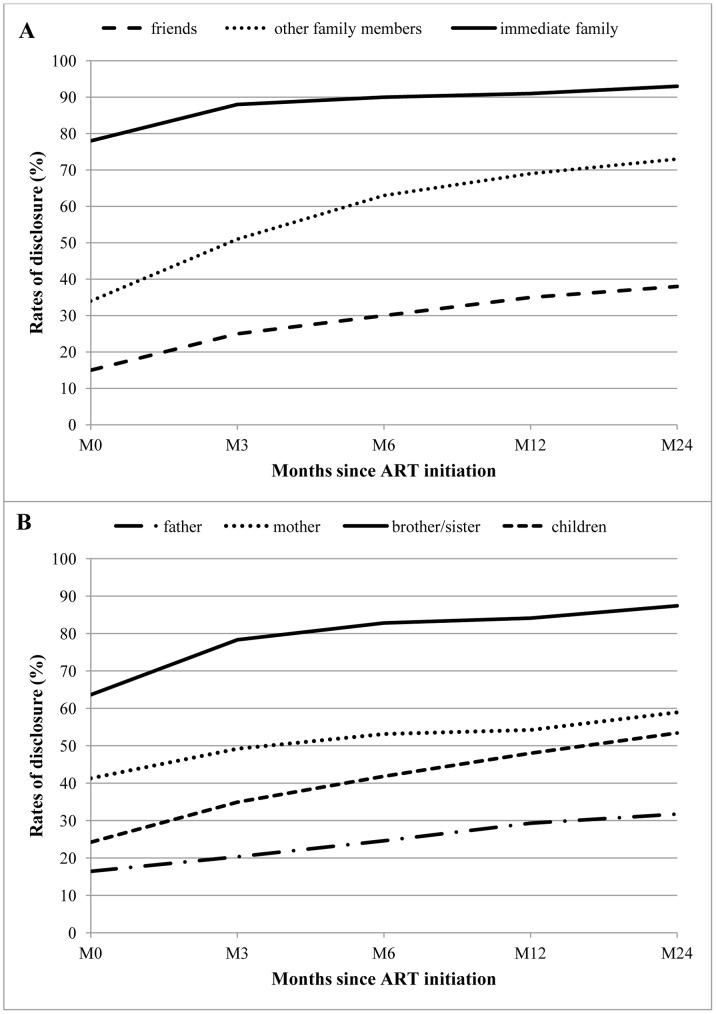
Overall rate of disclosure over time since initiating ART.The overall rate of disclosure to different categories of relatives and friends (panel A) and to different members among immediate family (panel B) was calculated at enrolment (M0) and at each follow-up time point (M3, M6, M12, M24) as the percentage of participants having revealed their serostatus to each of the relationship categories.